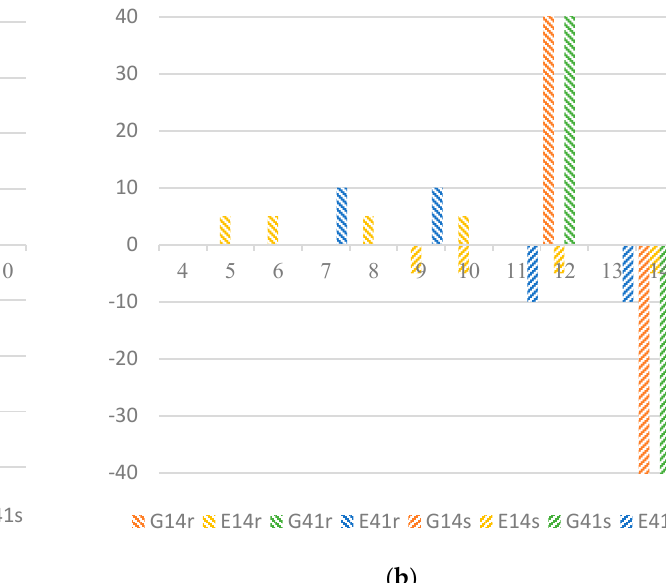
Figure 8. Optimal solution while T = 14. h represents time unit hours.